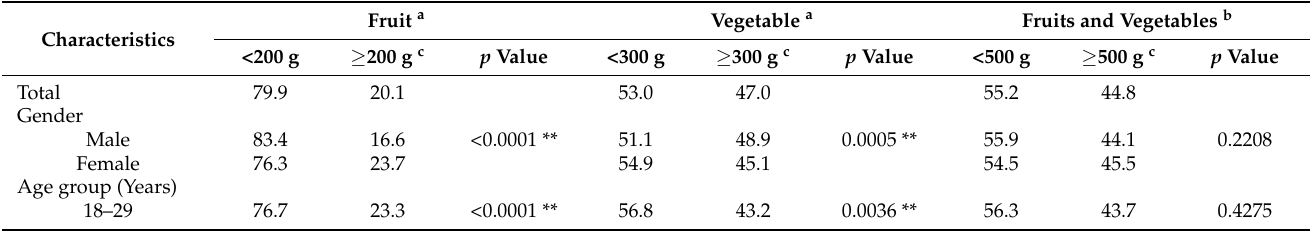
Table 3. Comparison between daily fruit and vegetable consumptions of Chinese labor force con- sumers with the recommended reference intakes